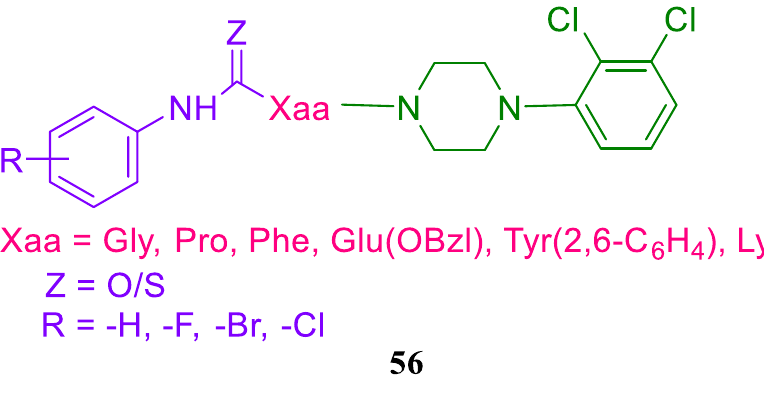
Figure 51. Urea/thiourea derivatives of amino acids conjugated 2,3-dichlorophenyl piperazine.